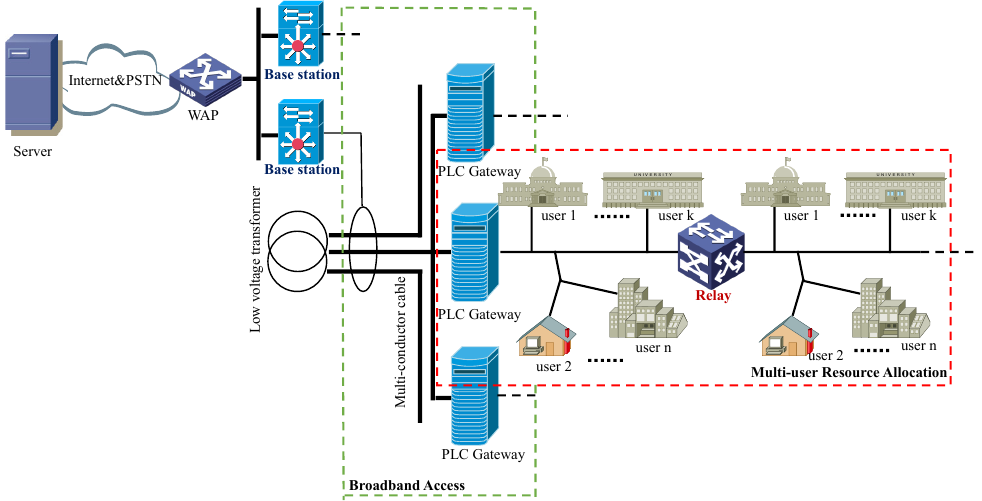
Figure 1. Diagram of the relay-aided power line communication (PLC)